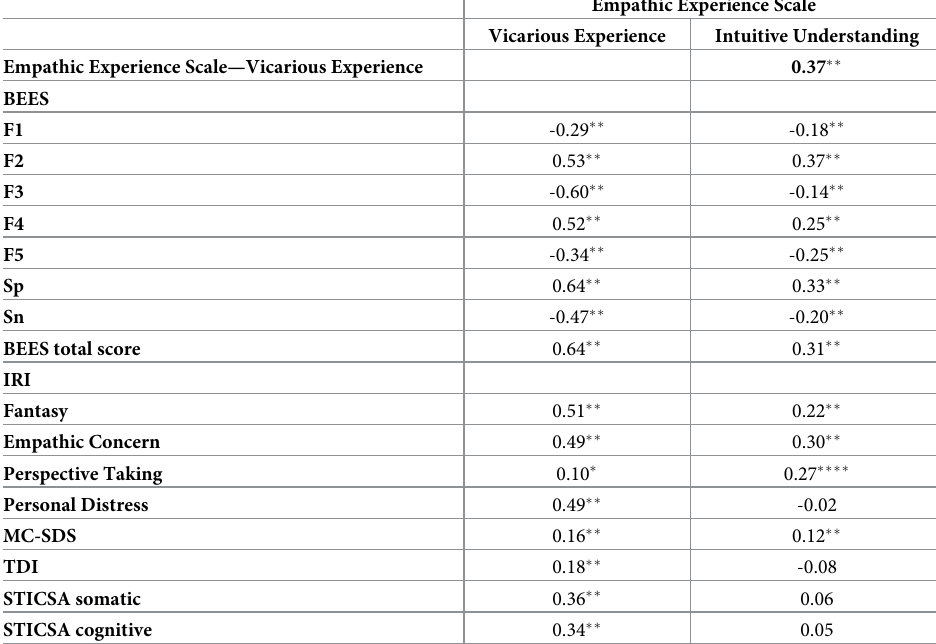
Table 3. Correlations among measures.